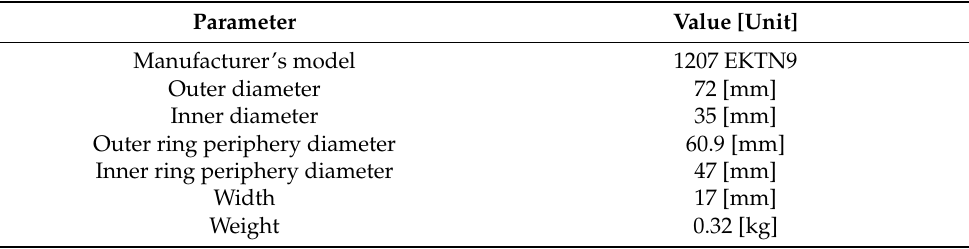
Table 3. Parameters of ball bearing SKF 1207K EKTN9 [90].